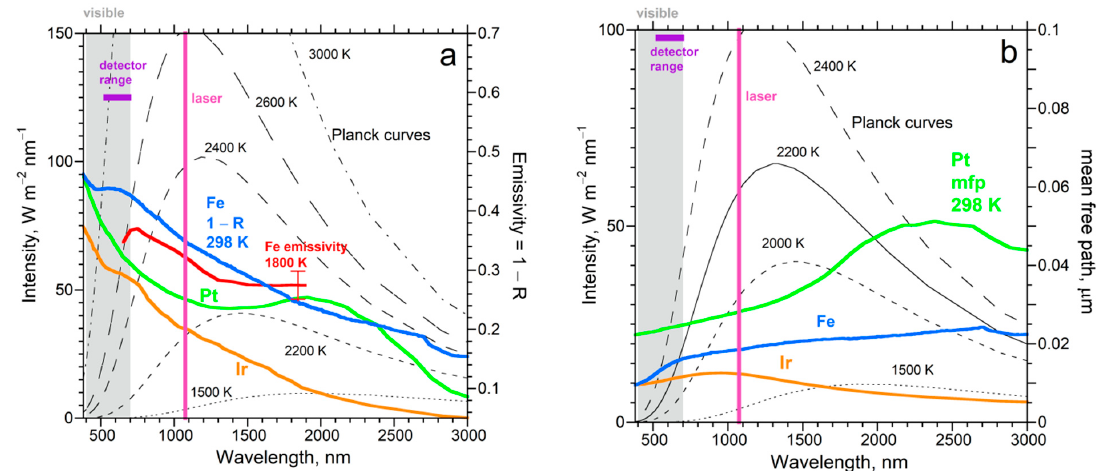
Figure 12. Spectra in the visible (grey rectangle) and near-IR (white background) wavelength ranges relevant to laser heating of foils. Thin patterned black curves = blackbody emissions with T as labeled. Green, blue or orange curves = metal spectral properties calculated from indices of refraction tabulated in [83]. Pink vertical line = the laser wavelength. Purple horizontal bar = range of the detector used in [30,81,82]: ( a ) Comparison with high- T emission data (red curve) from [84] to 1- r , which is reasonable for metals, due to opacity; ( b ) Comparison of mean free paths (=1/ A ) to blackbody curves for temperatures commonly explored in laser-heating DAC studies.